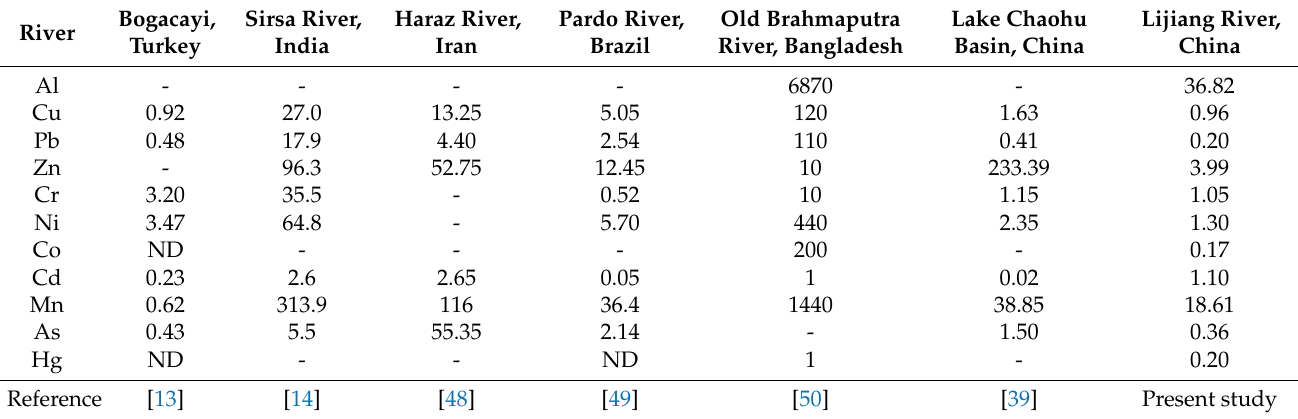
Table 4. Variation in heavy metal(loid)s concentration of different rivers across the